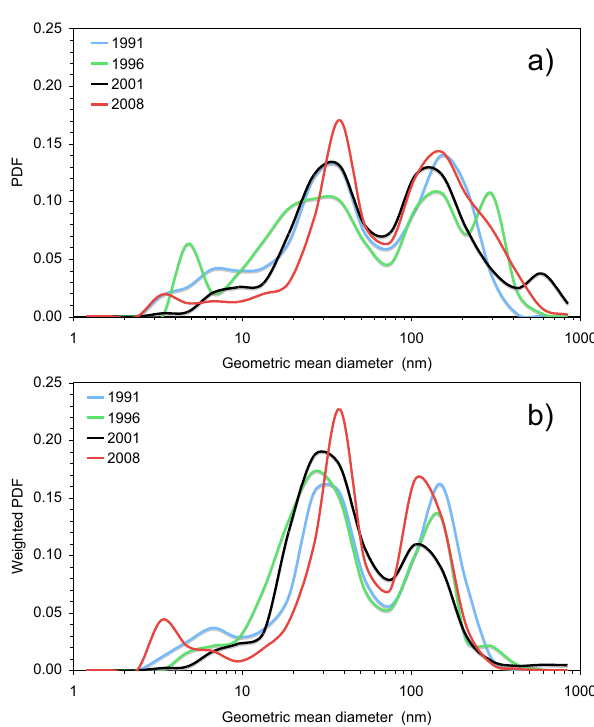
Fig. 6. (a) Probability density function PDF of geometric mean diameters of hourly number size distributions measured in 1991, 1996, 2001, and 2008 fitted with 2–6 lognormal modes; (b) PDFs weighted with the contributions of the respective modes to the ac- tual total number concentration.